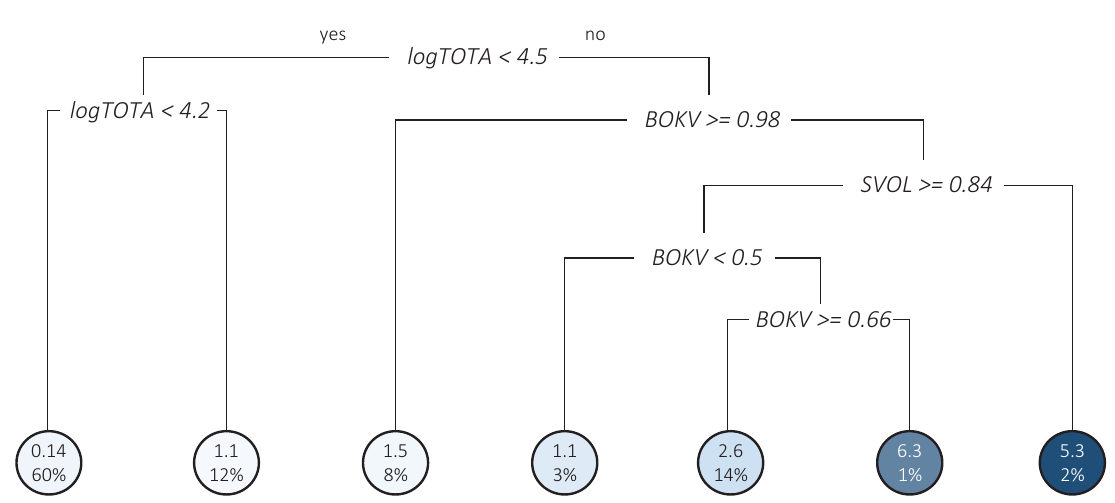
Pruned regression tree for